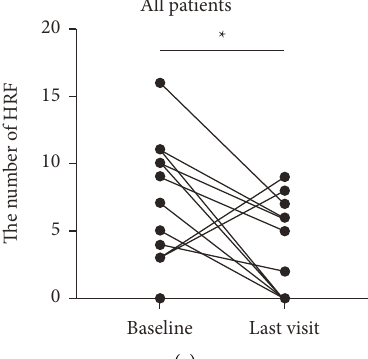
Figure 7: Representative image showing the change of HRF in patients with CSCR before and after anti-VEGF treatment. A 50-year-old female with CSCR, who was diagnosed with CSCR with visible CNV in the left eye, underwent three consecutive intravitreal injection of anti-VEGF treatments. (a) The baseline OCTA image showing SRF and HRF in his right eye. HRF (yellow arrow) were measured within the length of 1,000 μ m (red double-head arrow) between 2 vertical lines centered on the fovea. (b) The number of HRF was decreased ac- companying partial SRF resolution after anti-VEGF treatment. (c) The changes of HRF for all the patients. HRF, hyperreflective foci; SRF, subretinal fluid. The statistics was analyzed by the paired t -test,